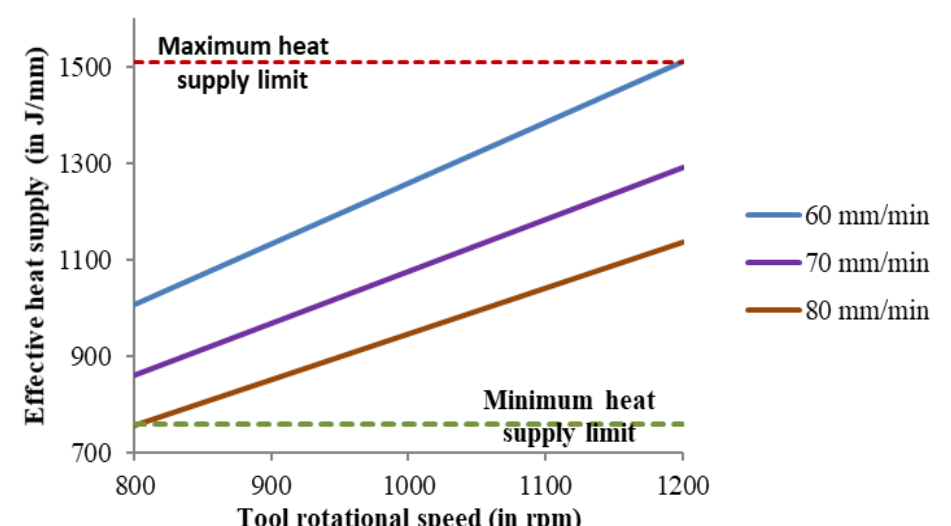
Figure 4. Optimum effective heat supply (Hexagonal